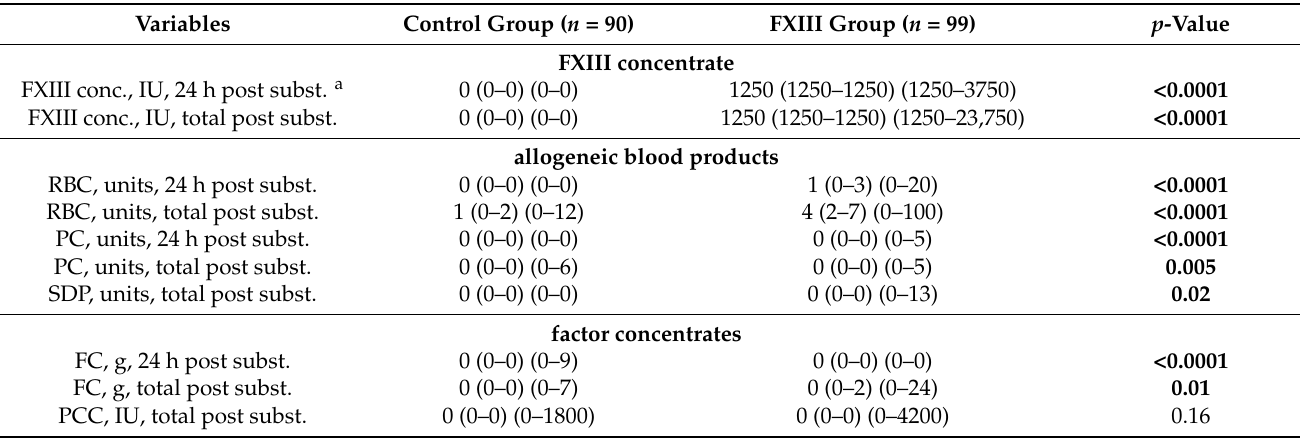
Table 2. Use of allogeneic blood products and coagulation factor concentrates after initial FXIII level measurement.